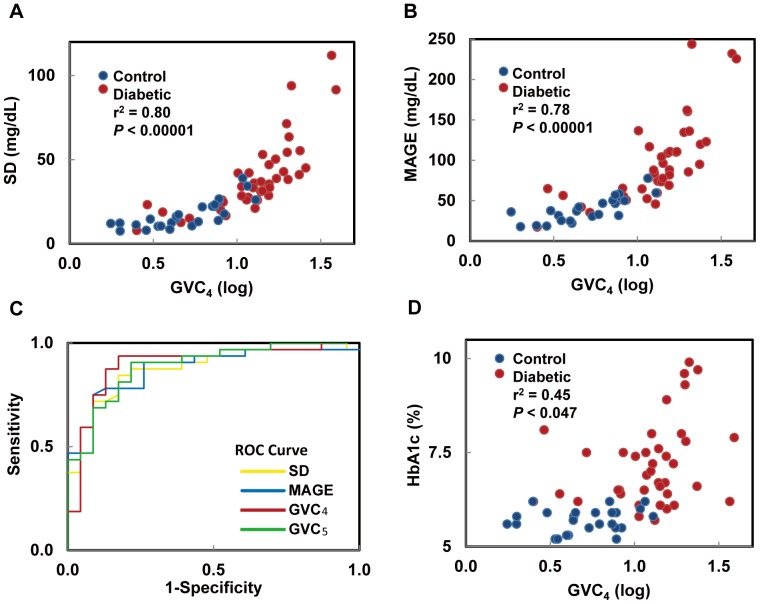
Relationships between the fourth glycemic variability cycle (GVC4) and conventional measures of glycemic control.The degree of glycemic variability within GVC4 was highly correlated with SD (A) and MAGE (B), but the areas under the curves of GVC4 and GVC5 were greater than SD and MAGE (C). The degree of glycemic variability within GVC4 was highly correlated several markers of glucose control including HbA1c (D). As with GVC4 (the cycle linked with meal intake), the example in this figure, similar relationships were observed for all other GVC cycles. The r2 and P values represent the least square model fit.